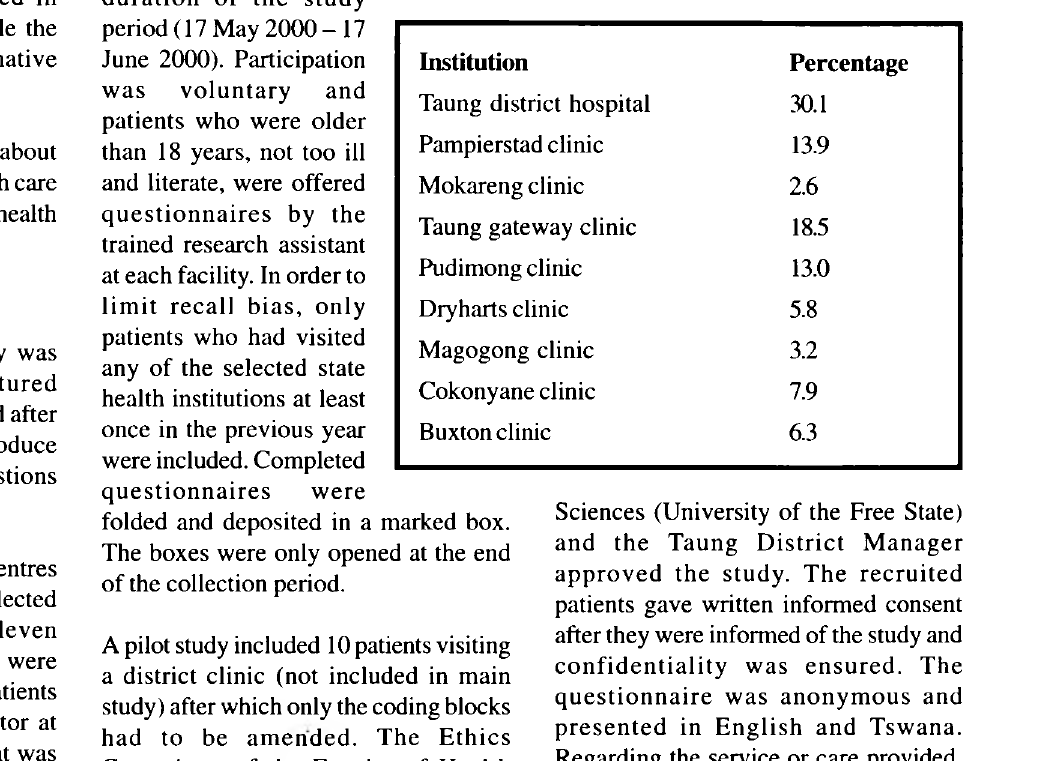
Table 2: Patient satisfaction with services